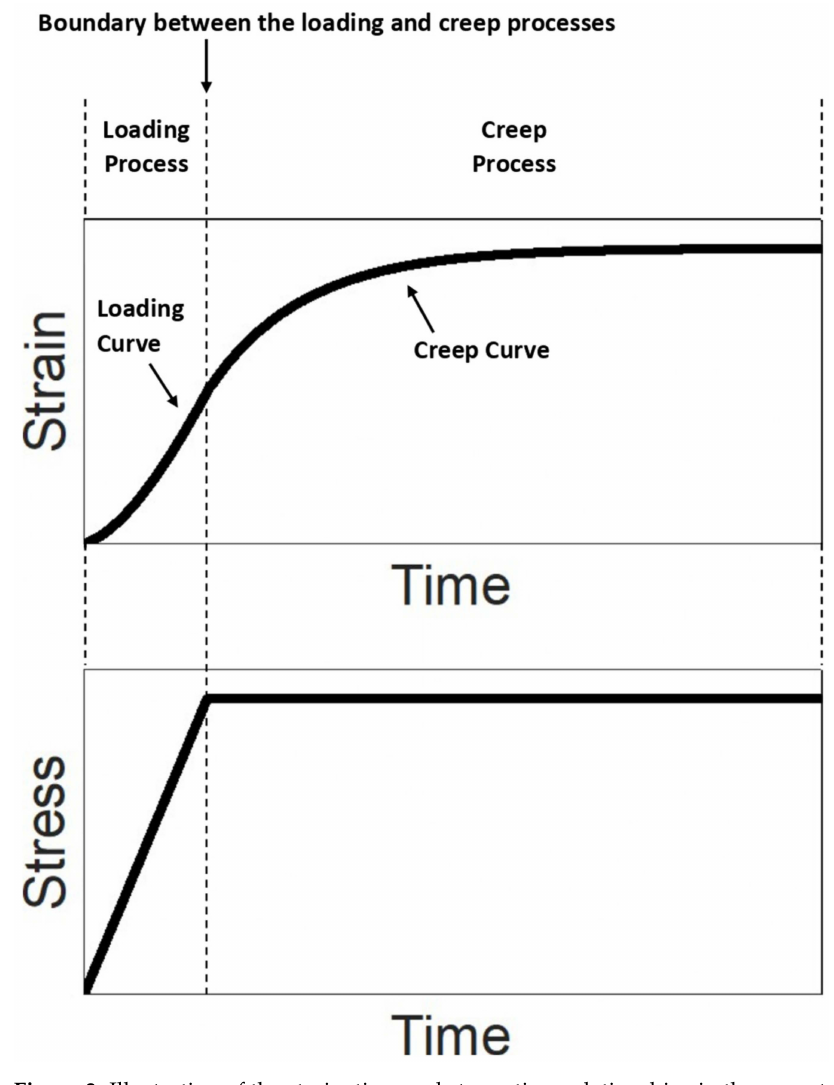
Figure 3. Illustration of the strain–time and stress–time relationships in the creep